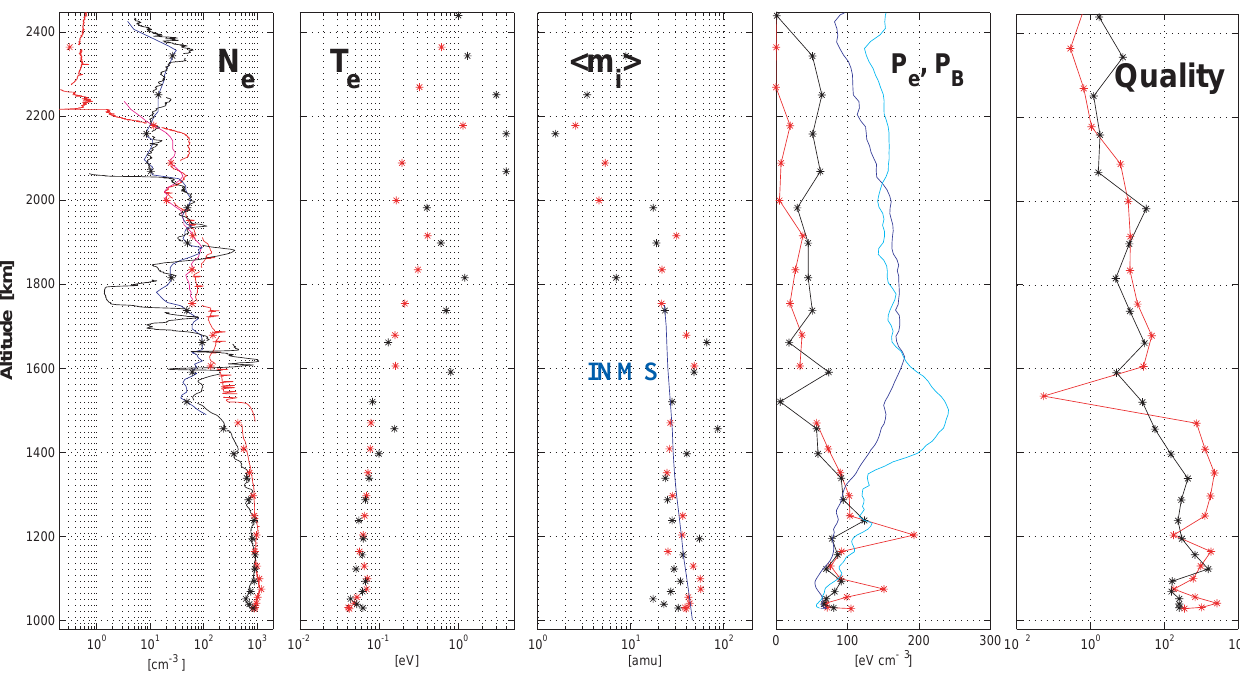
Fig. 5. Range profiles of RWPS derived parameters from the T5 flyby. The outbound (black) and inbound (red) values compare well on the average except for T e at high altitudes (panel 2). In panel 1 the different curves are LP sweeps (stars), LP 20Hz (black or red line) and f UH derived densities (pink = inbound, blue = outbound). The INMS values for m i from Cravens et al. (2006) are superposed (panel 3, blue line) on the LP derived m i . Panel 4 shows the thermal, P e = n e k B T e , (red = inbound, black = outbound) and the magnetic, P B = B 2 /( 2 µ 0 ) , (blue = inbound, cyan = outbound) pressures. The quality factor is shown in panel